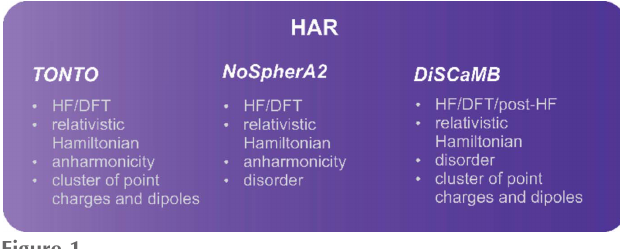
Figure 1 Available software for HAR and their most important